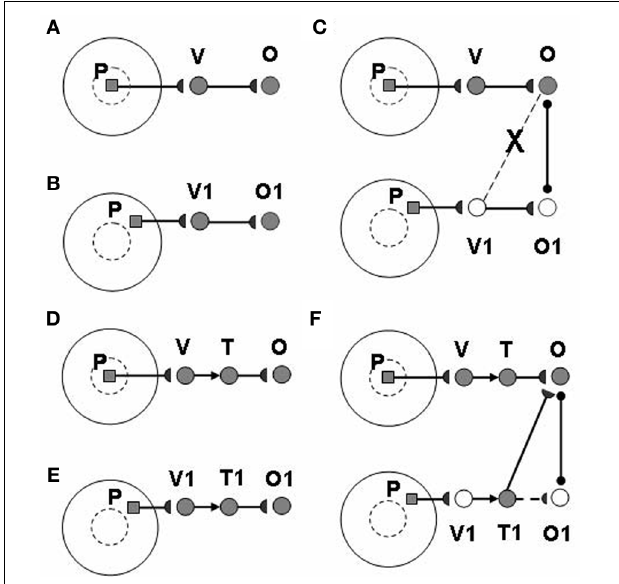
FIGURE 3 | How the view category integrator helps to learn a positionally-invariant object category. See text for details. [Reprinted from Cao et al. (2011), Figure 4, with permission].